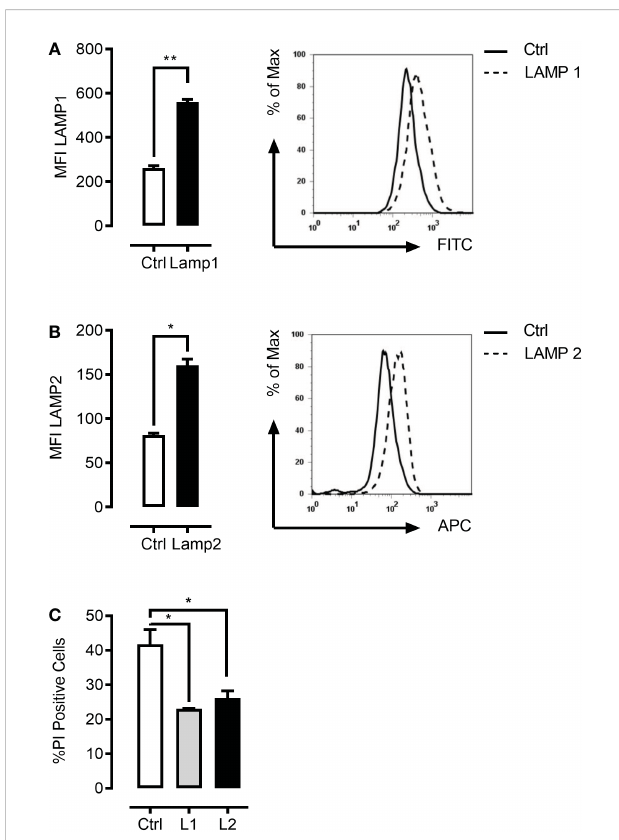
FIGURE 7 LAMP1 and LAMP2 overexpression rescue me fl oquine and mTOR inhibition-mediated cell death. K562 cells were lentivirally infected with LAMP1-GFP or LAMP2-RFP overexpressing plasmids. Flow cytometric based intracellular staining analysis con fi rmed signi fi cant overexpression of both LAMP1 (A) and LAMP2 proteins (B) . (C) K562 cells were sorted with the help of their fl uorophore and selected cells were subjected to pp242 (5 m M) and me fl oquine (10 m M) treatment for 24 h and cell viability was measured using PI. LAMP1 and LAMP2 overexpressing cells had a signi fi cantly lower percentage of cell death when compared to scramble control. Data represent mean ± S.D. and is representative of 2 independent experiments each with 2-3 replicates. *p < 0.05, **p < 0.01, ***p < 0.001 by student ’ s t-test ( A, B ) or One-way ANOVA with Dunnet ’ s multiple comparison tests (C) *P < 0.05; **P < 0.01; ***P <